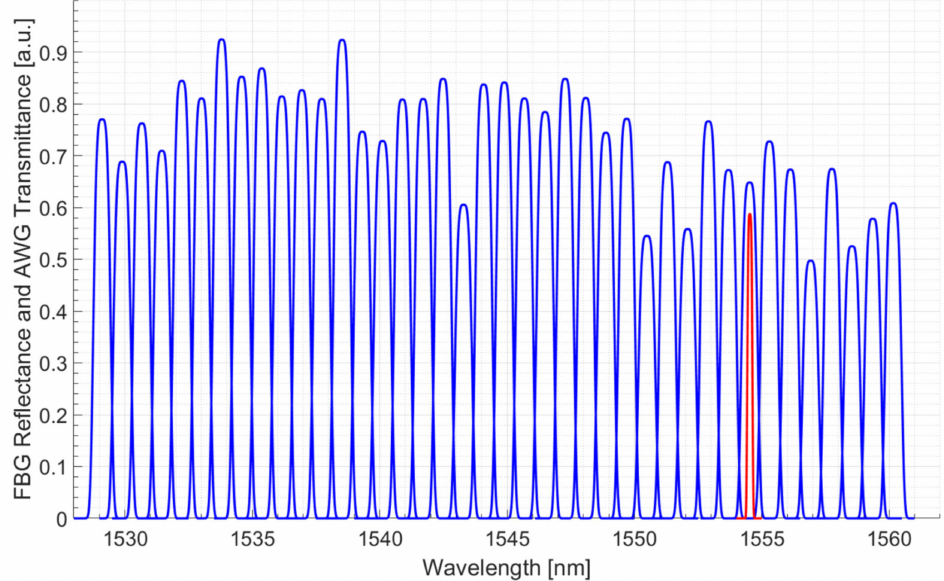
Figure 2. AWG employed spectrum (blue) with the superposition of a 200 pm FWHM FBG sensor (red).